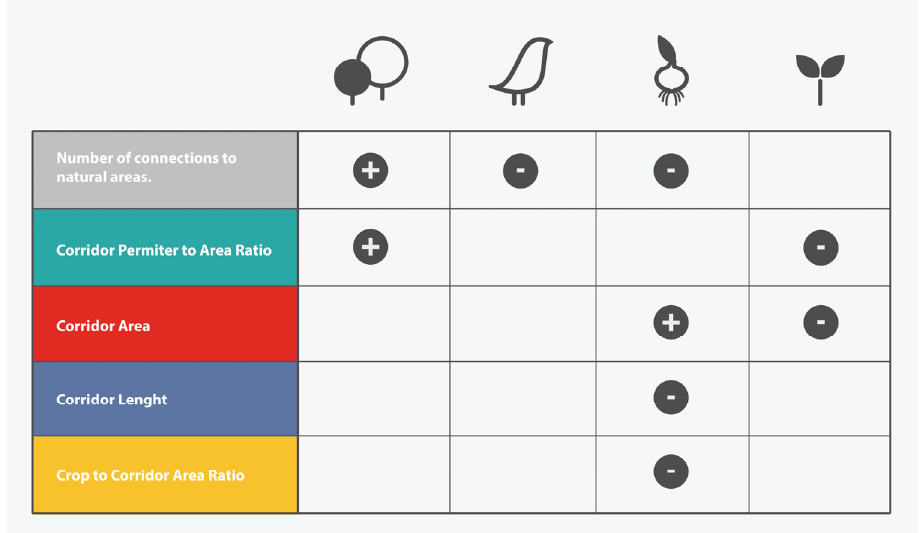
Figure 6. Relationship between ecological indicators and corridor traits. Colored circles indicate significant statistical relationships and (+) or (-) signs show positive or negative correlations. From left to right: “Tree regeneration”, “Avian indicator species”, “Geophytes”, and “Woody plant coverage”.